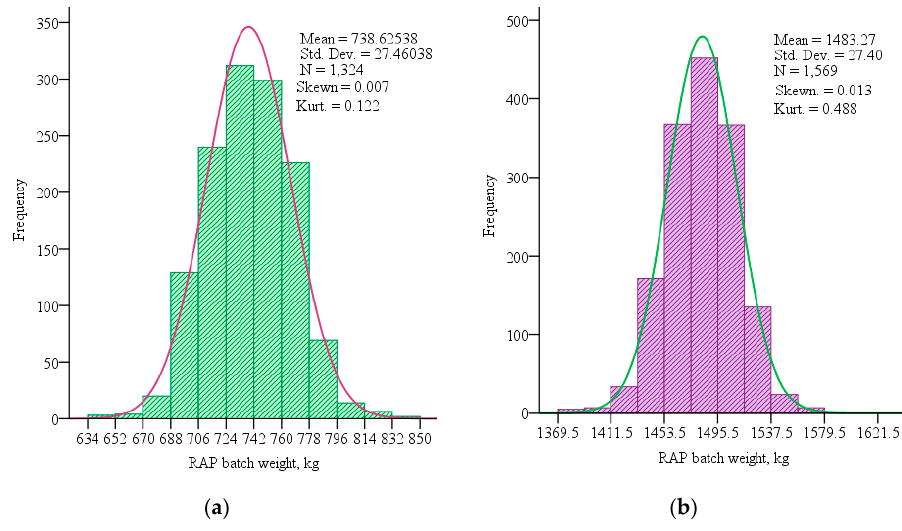
Figure 7. Distribution histograms, theoretical curves of normal distribution and statistical parameters of RAP batch masses in HMA batches of mixtures: ( a )—AC 16 PD (750 kg); ( b )—AC 22 PS (1500 kg). Table 2. RAP composition, %.